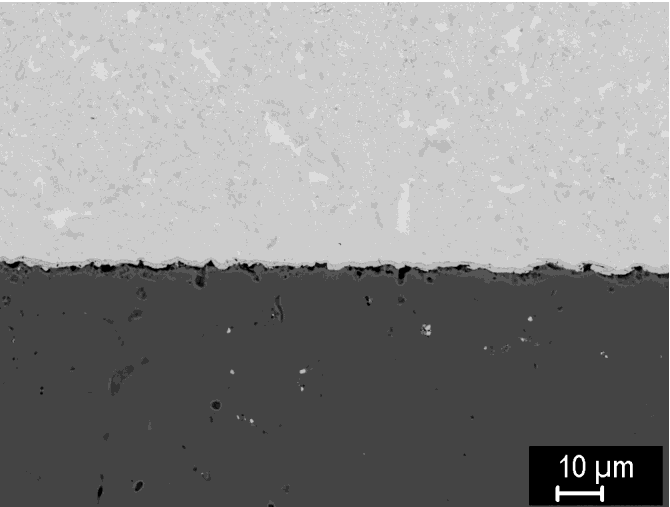
Figure 13. Detail of a direct joint of pure steel ( bottom ) and pure tungsten ( top ) pellets joined at 1100 °C.